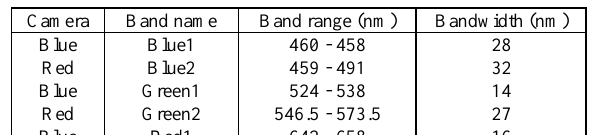
Spectral characteristics of the MicaSense RedEdge MX Dual Camera Imaging System (MicaSense Inc., 2019).